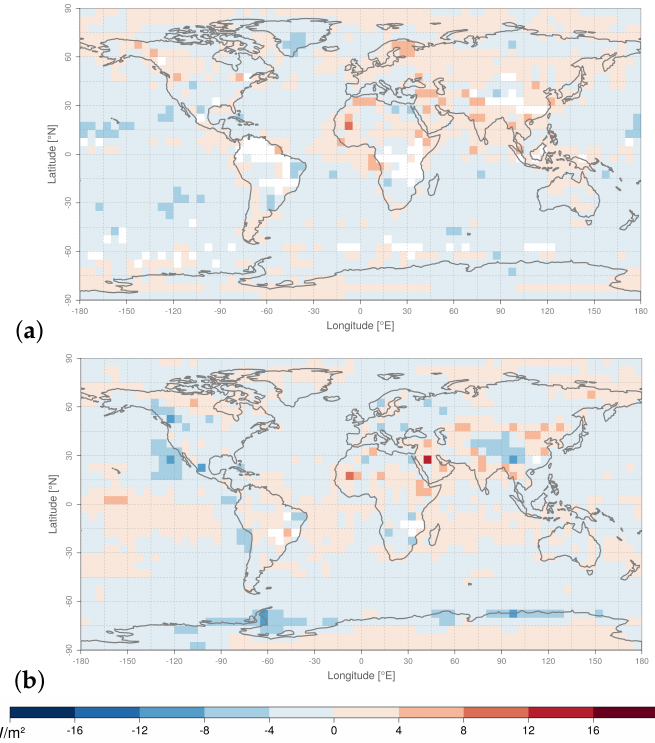
Figure 5. Flux-equivalent Mean Bias ( MB flux ) between observed and estimated broadband reflectance, for ( a ) clear-sky and ( b ) all-sky conditions; estimated values are calculated by applying surface-type-dependent regressions on the narrowband observations, using all predictors (full regression model). Biases are calculated on expanded validation database (with relaxed matching